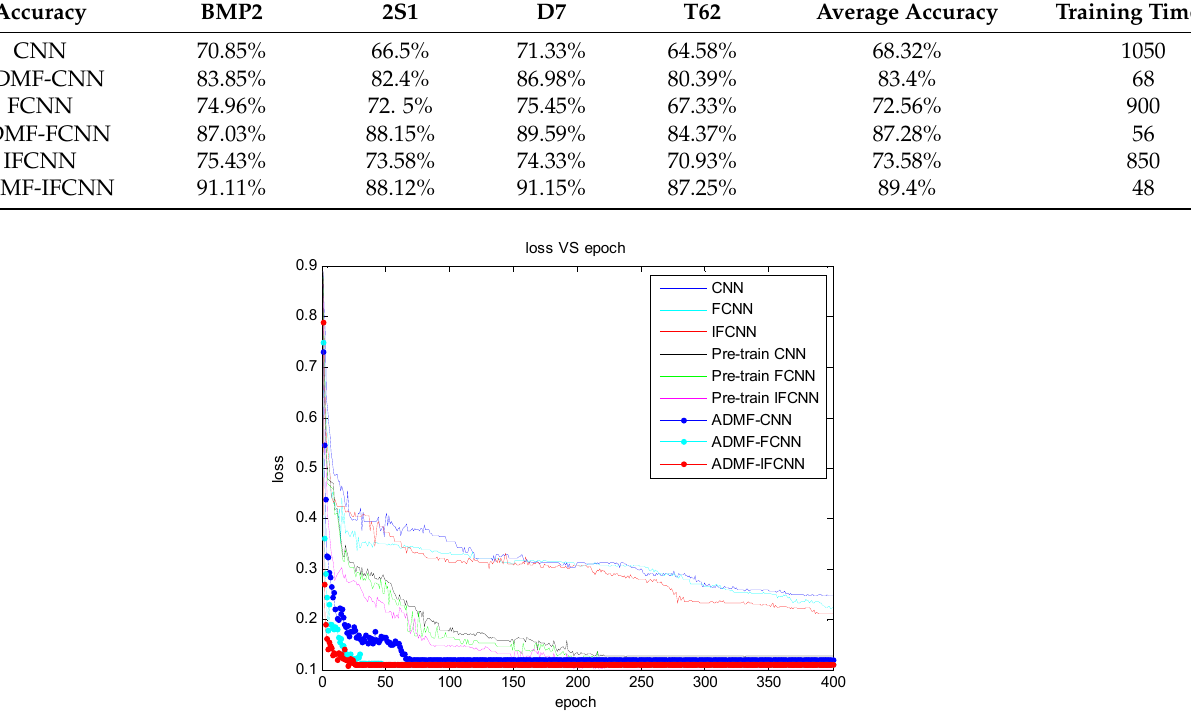
Figure 11. Training loss curves of classification models.